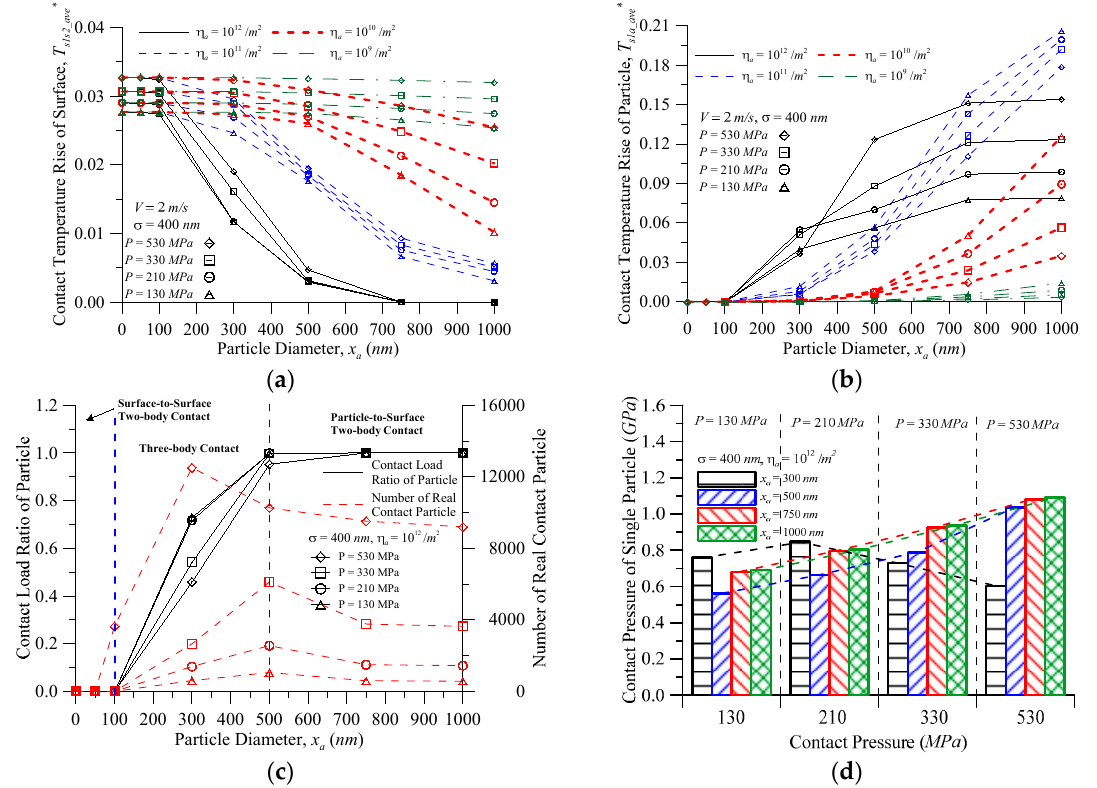
Figure 7. The characteristic of the particle and surface vs. the particle diameter at various contact pressures and area density of particles for ( a ) the contact temperature rise of the surface; ( b ) the contact temperature rise of the particle; ( c ) the contact load ratio of the particle and number of real contact particles; and ( d ) the contact pressure of a single particle.